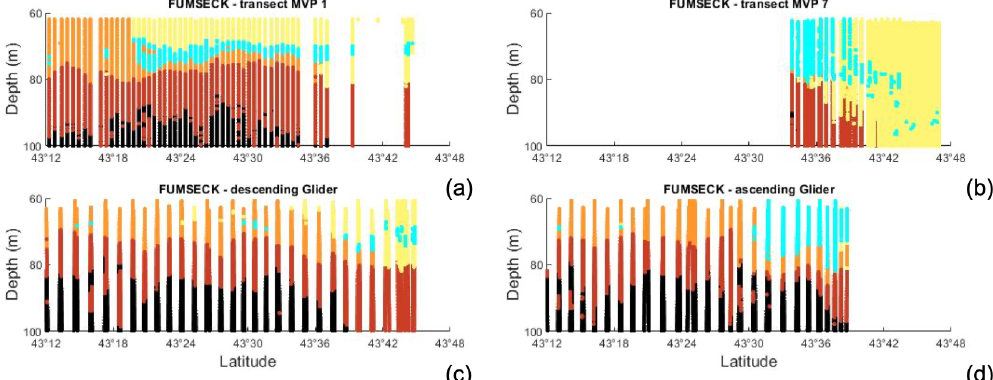
Figure 8. Vertical transects versus longitude with associated coloured waters from (a) MVP 1, (b) MVP 7, (c) descending glider data (southward transect), and (d) ascending glider data (northward